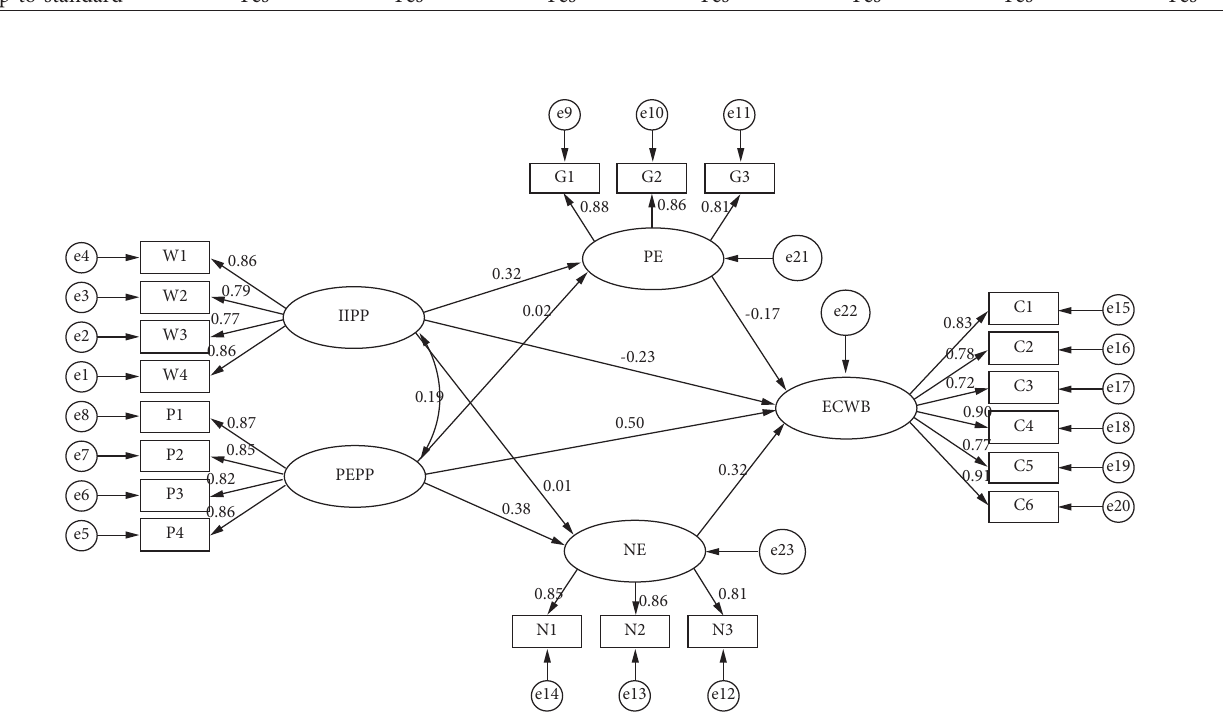
Figure 2: Structure path diagram. Table 6: Path coefficients of structural equation